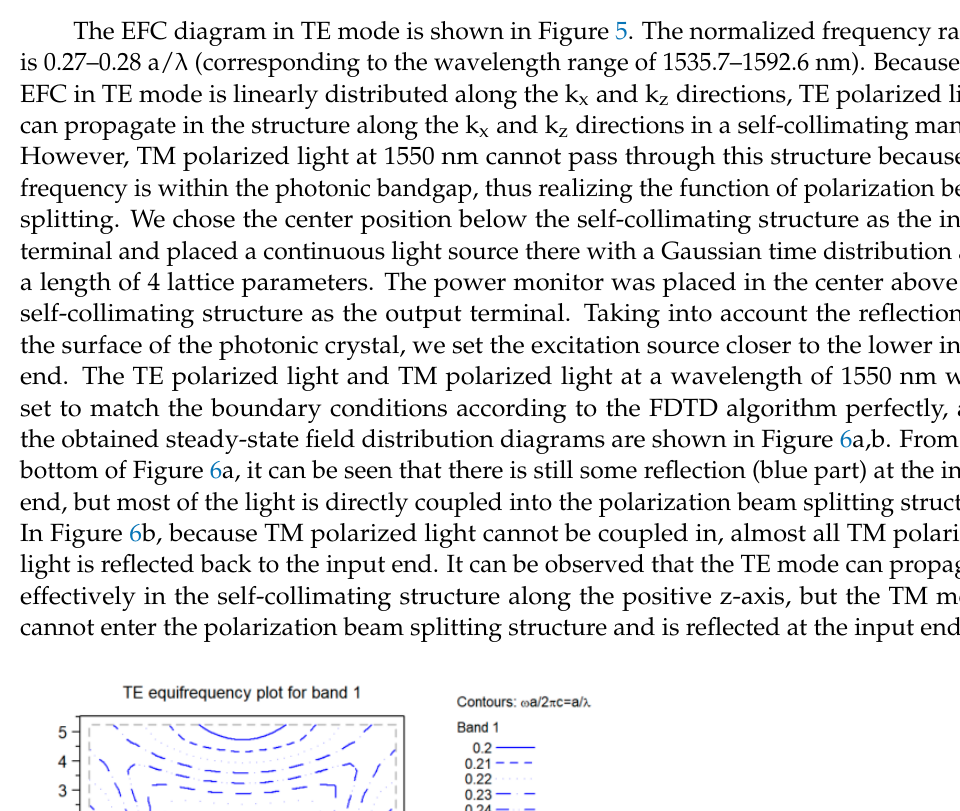
Figure 4. ( a ) Polarization beam splitting structure; ( b ) Energy band diagram of polarization beam splitting structure.